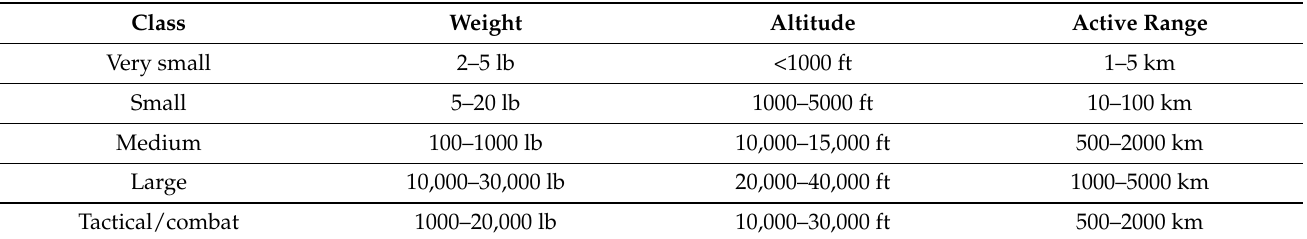
Table 1. UAV classification